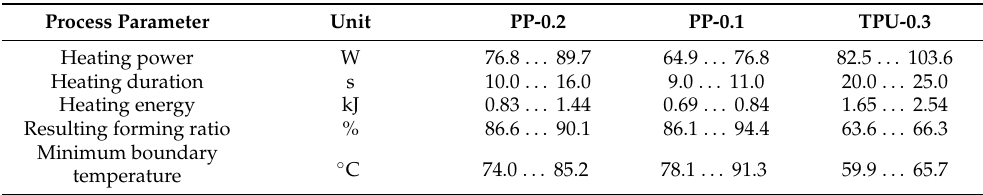
Table 4. Value ranges of process parameters and the corresponding boundary temperatures and forming